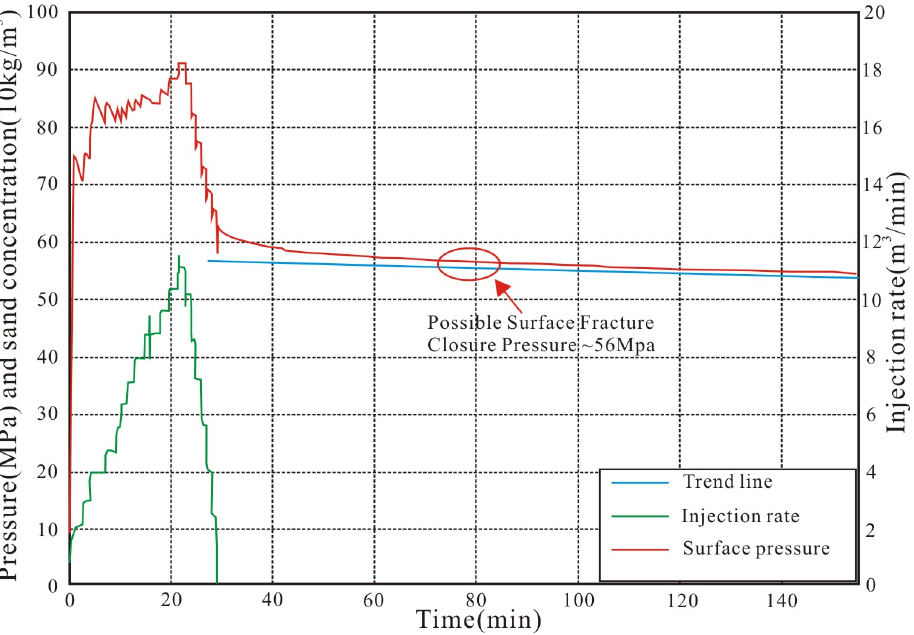
Figure 13. Mini-frac test pressure curve in W205.